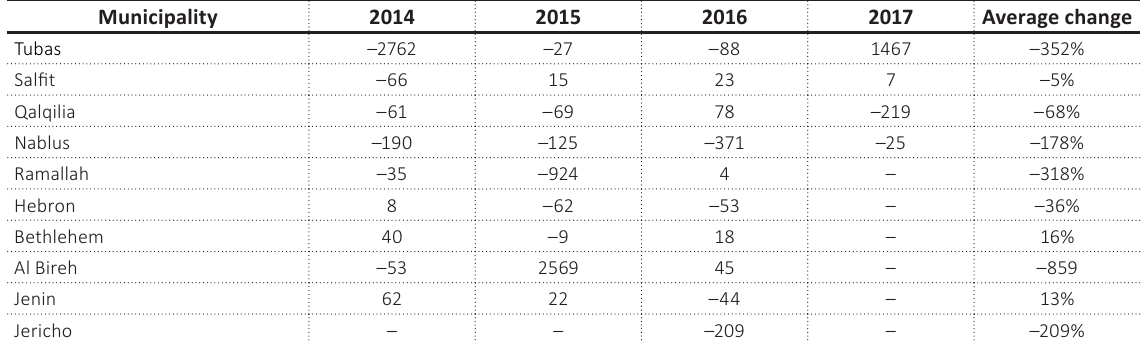
Table 6. Net income growth rates (%) for the period